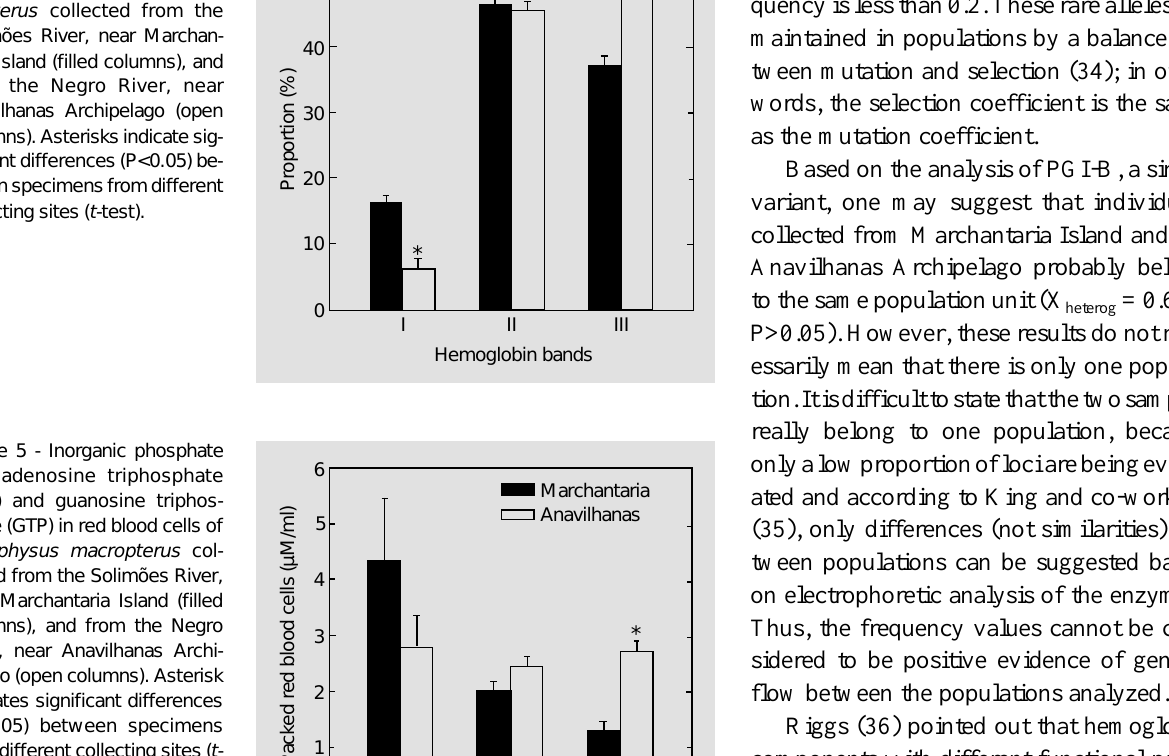
Figure 4 - Relative concentration (%) of electrophoretic hemoglo- bin bands of Callophysus ma- cropterus collected from the Solimões River, near Marchan- taria Island (filled columns), and from the Negro River, near Anavilhanas Archipelago (open columns). Asterisks indicate sig- nificant differences (P<0.05) be- tween specimens from different collecting sites ( t -test).